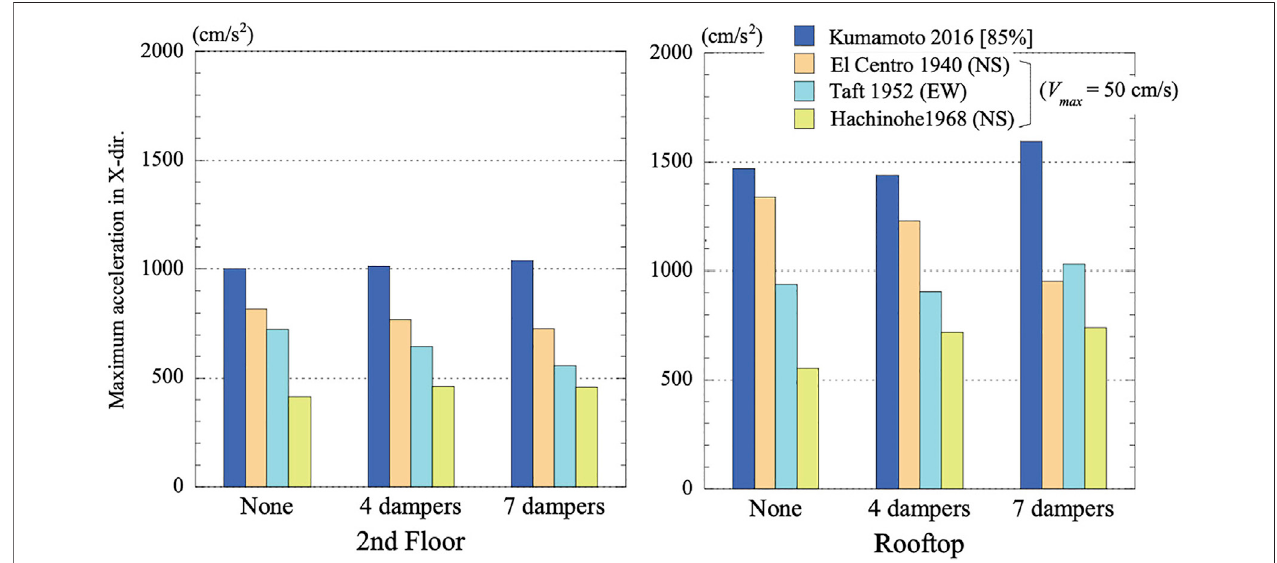
FIGURE 13 | Maximum 2nd- fl oor and rooftop acceleration of the timber frame